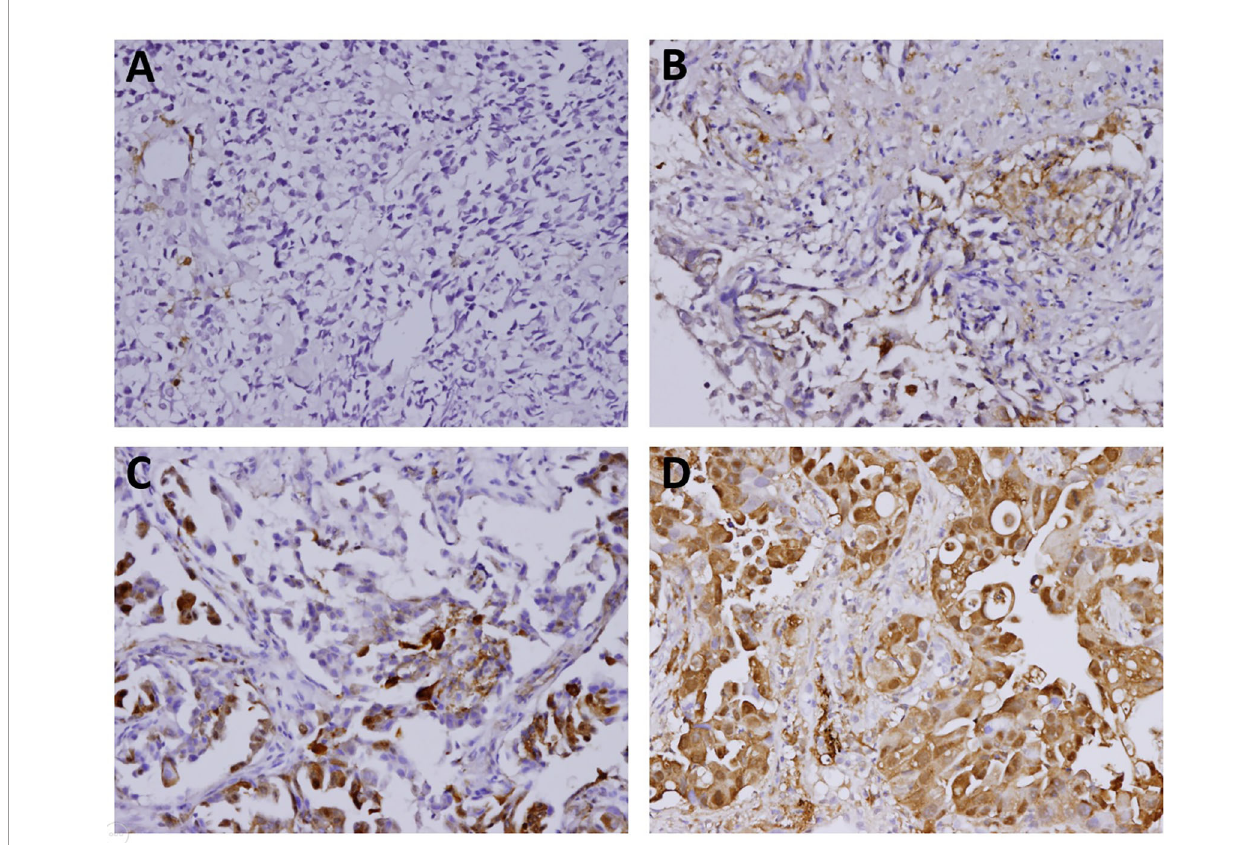
FIGURE 2 | The immunostaining features of tumor galectin-3 expression. The percentages of positive staining for galectin-3 in the tumor part were scored as follows: (A) Score 0 for <10% positive staining; (B) Score 1 for 10% to <40% positive staining; (C) Score 2 for 40% to <70% positive staining; (D) Score 3 for at least 70% positive staining. Original magni fi cation